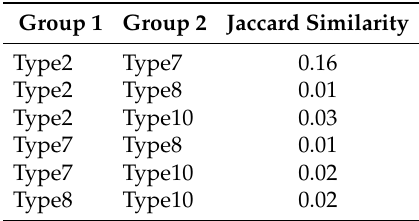
Table 2. Population comparison. Reporting Jaccard similarity of sets of patient ids in the two